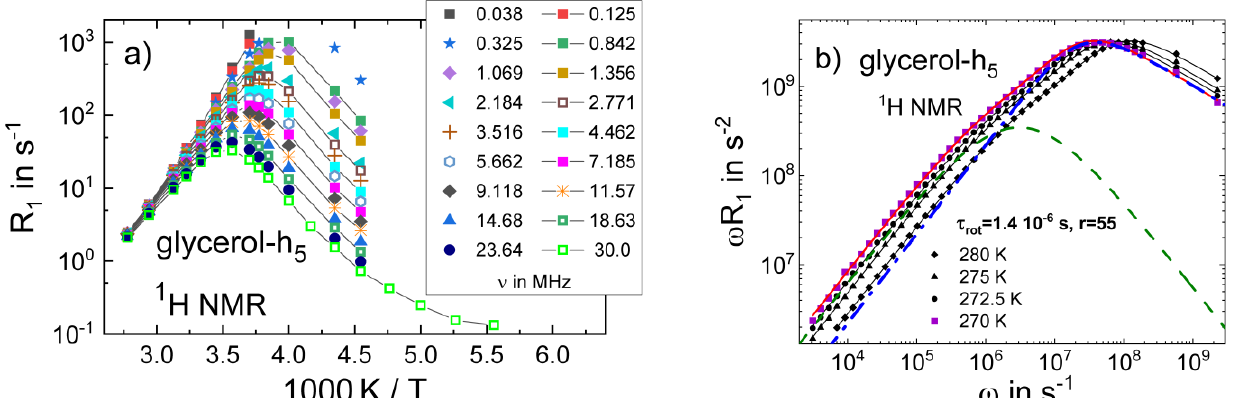
Figure 1. ( a ) 1 H relaxation rate R 1 of partially deuterated glycerol-h 5 at exemplary Larmor frequencies ( ω /2 π ) as a function of reciprocal temperature [35]; a spectral range typical of commercial FC relaxometers is covered. The lines are guides to the eye. ( b ) Susceptibility spectrum χ ”( ω ) = ω R 1 ( ω ) as obtained from a home-built instrument together with high-field data. The red solid line represents a fit by a sum of two sub-spectra referring to the translational (dashed line) and rotational (dashed-dotted line) relaxation contributions at 270 K, yielding the indicated parameters (see text for details).